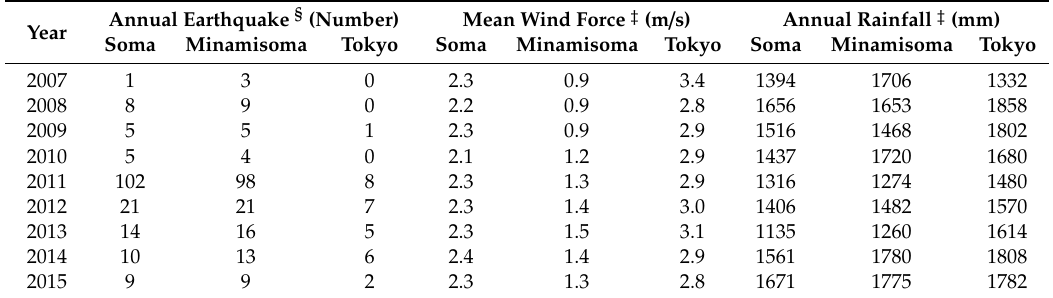
Annual earthquakes (number), mean wind force (m / s), and annual rainfall (mm) during 2007–2015. Annual Earthquake § (Number) Mean Wind Force ‡ (m / s) Annual Rainfall ‡ (mm) Soma Minamisoma Tokyo Soma Minamisoma Tokyo Soma Minamisoma